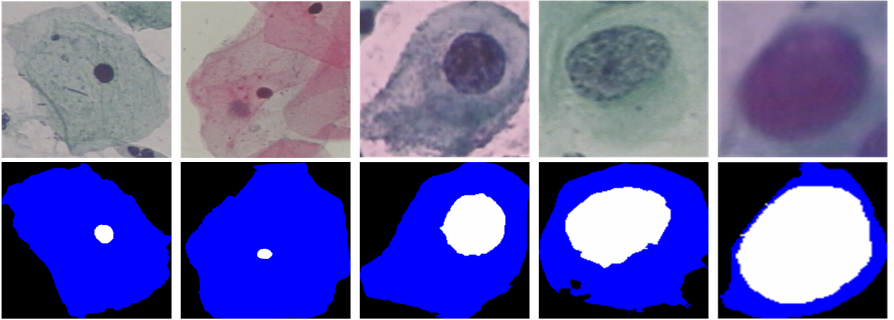
Figure 1. The two columns on the left are normal cervical cells and the three columns on the right are infected cervical cells. Normal cervical cells have tiny and compact nuclei. When cervical cells are infected, the nuclei first appear abnormal in shape, color, and texture, among other